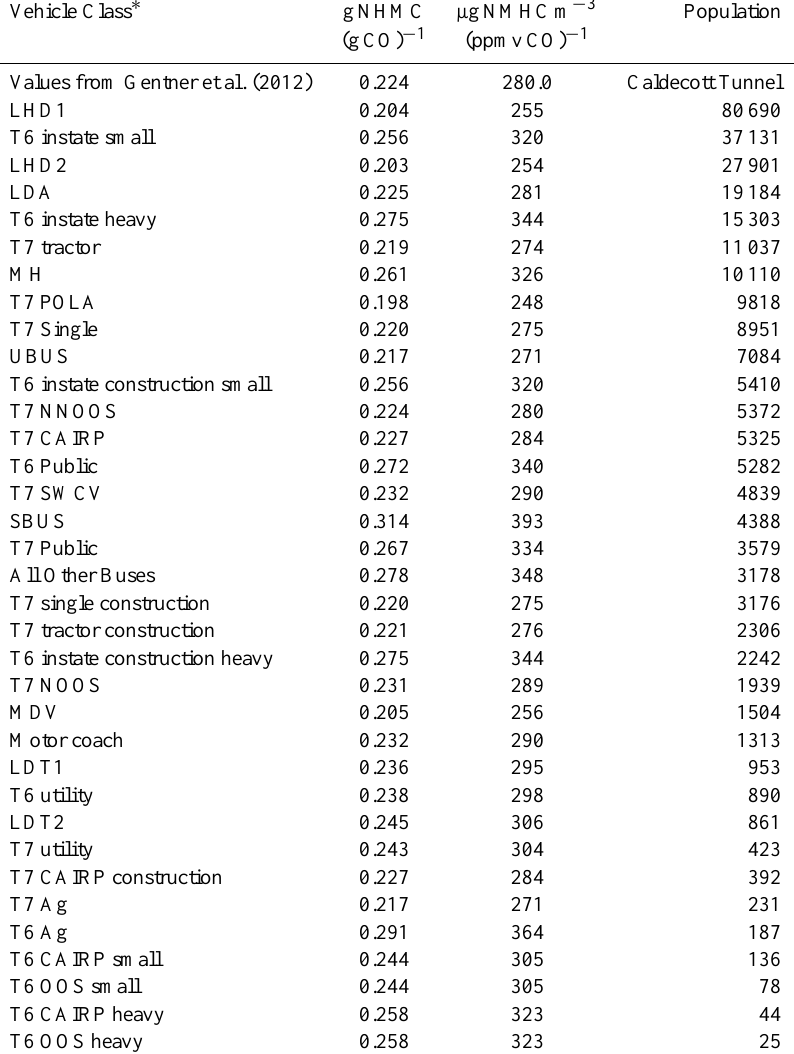
Table 4. Diesel vehicle-specific emission ratios, EF NMHC /EF CO , predicted by EMFAC2011 (http://www.arb.ca.gov/emfac/) for the South Coast Air Basin in summer 2010. Emission ratios are based on daily CO and NMHC emission rates calculated by EMFAC2011. Emission ratios include all drive-cycle components (i.e., running, idle, start, diurnal evaporative, hot-soak evaporative, running evaporative, and resting evaporative). Rows are ordered in descending population. Numerical values in µgNMHCm − 3 (ppmvCO) − 1 columns are calculated using the conversion factor 1250µgCOsm − 3 (ppmvCO) − 1